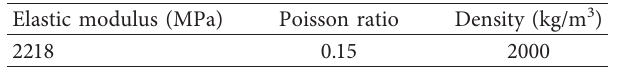
Table 1: Basic parameters of masonry materials.